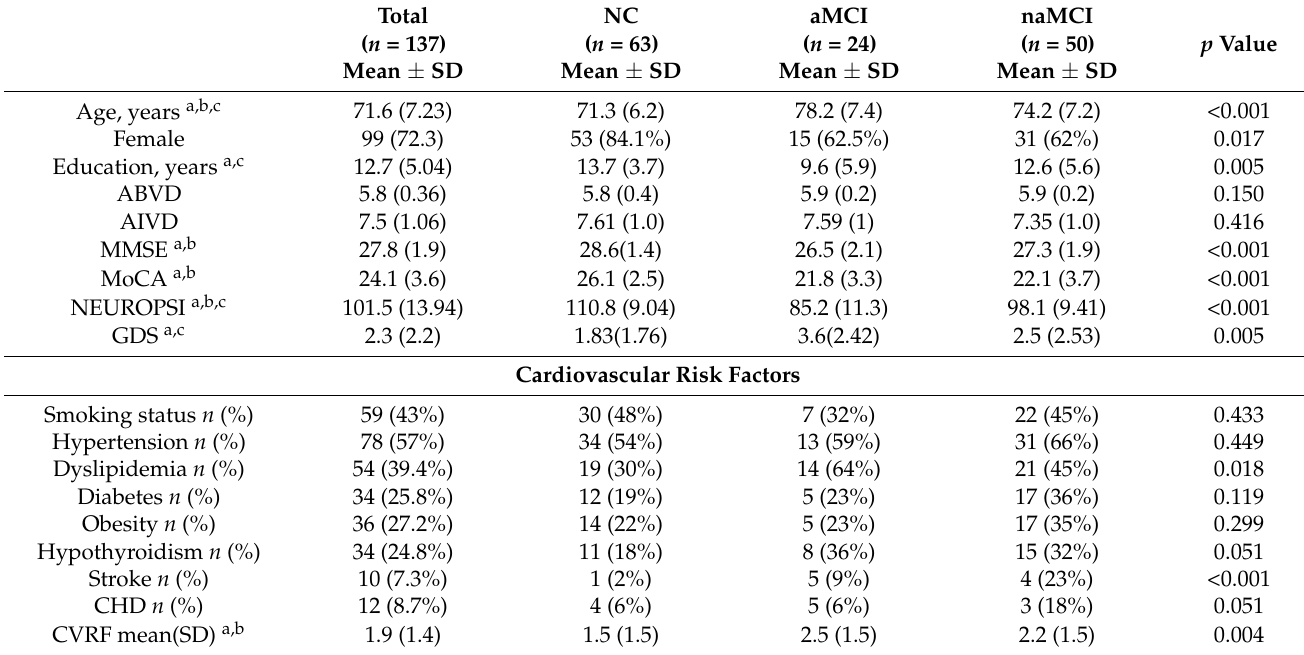
Table 1. Sociodemographic and health characteristics, cognitive performance scores, cardiovascular risk factors, and ApoE Genotype in the NC, aMCI and naMCI